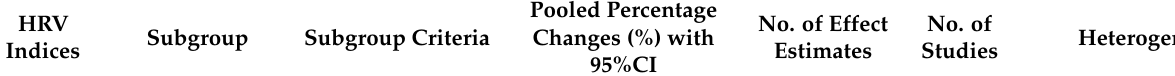
Table 3. Subgroup analysis of percentage change in indicators of HRV in association with each 10ppb increase in short-term O 3